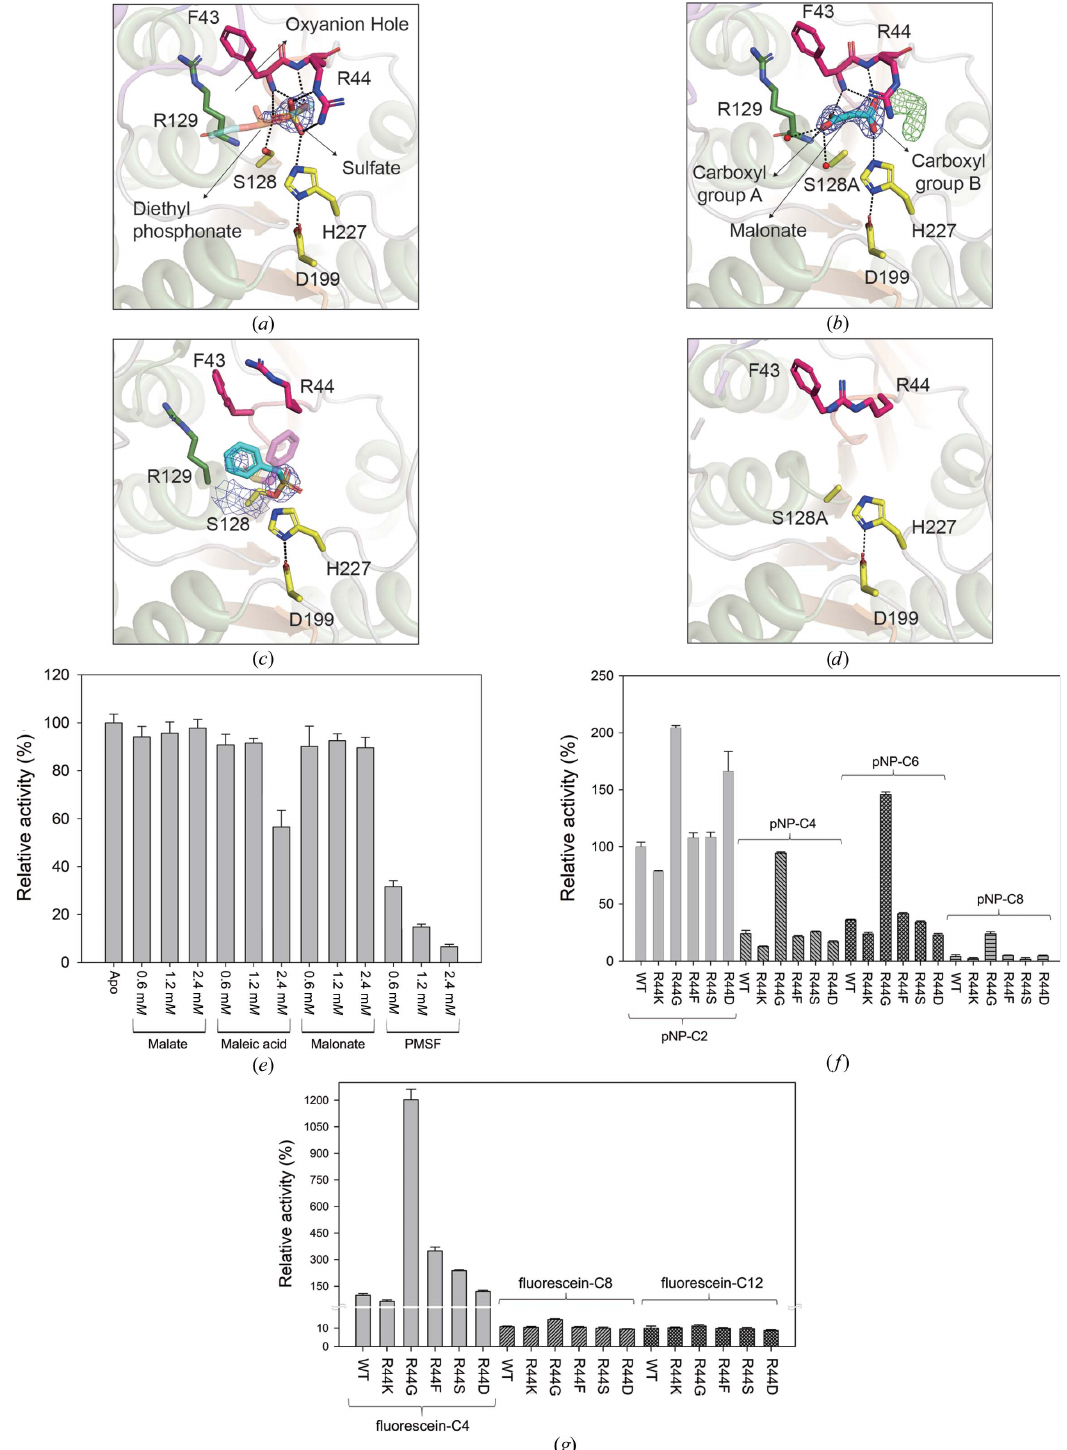
Figure 5 Binding modes of various ligands. The active sites of the sulfate-bound structure ( a ), malonate (MLA)-bound S128A mutant structure ( b ), PMSF-bound structure ( c ) and S128A mutant structure ( d ) are shown. The overall color scheme of PsEst3 is the same as that in Fig. 1( a ). The 2 F o (cid:4) F c map of sulfate and malonate (blue) and the F o (cid:4) F c map of unidentified ligands (green) are contoured at the 2 (cid:6) level except for in the PMSF complex (1.5 (cid:6) level). The hydrogen bonds between ligands and PsEst3 are represented as black dotted lines. The transition-state analog (diethyl phosphonate)-bound structure of an extracellular triglyceride lipase (PDB entry 4tgl) and the PMSF-bound structure of EstE5 (PDB entry 3h17) are superposed on PsEst3, and the diethyl phosphonate in PDB entry 4tgl and the PMSF in PDB entry 3h17 are represented as transparent stick models in ( a ) and ( c ), respectively. ( e ) Inhibition activity by malate (salt form), maleic acid, malonate and PMSF. The respective ligand was added in the concentration range 0.6–2.4 m M . ( f ) The p NP-ester (C2, C4, C6 and C8) hydrolysis activity measured with various Arg44 variants (R44K, R44G, R44F, R44S and R44D). ( g ) Relative activities of fluorescein derivatives (C4, C8 and C12) measured with various Arg44